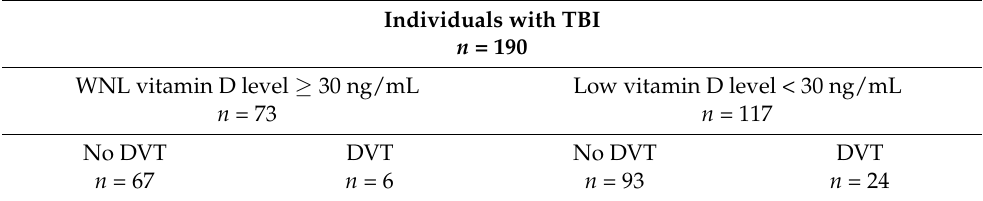
Table 2. Group distribution, DVT occurrence, and supplementation in individuals with WNL and low vitamin D levels receiving acute inpatient rehabilitation for moderate–severe